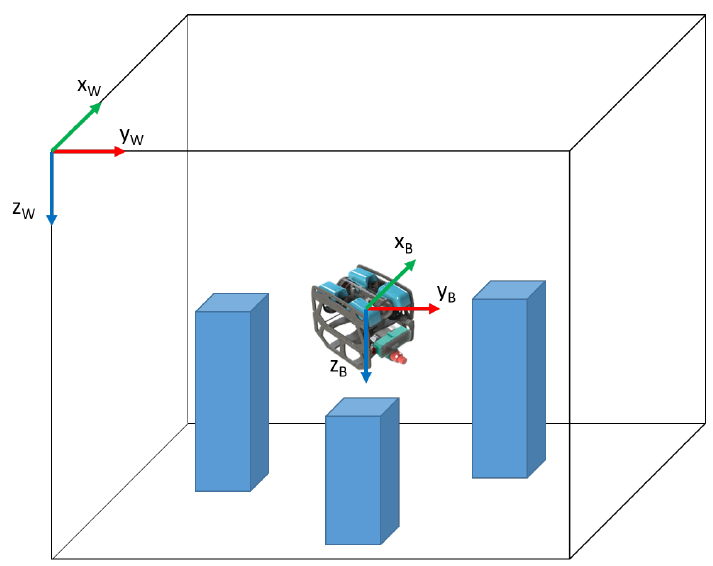
Figure 1. World-fixed and Body-fixed Axis